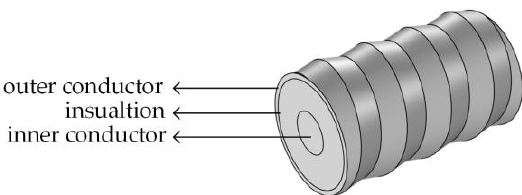
Figure 1. Oblique diagram of a section of the phase stable cable with a corrugated outer conductor.